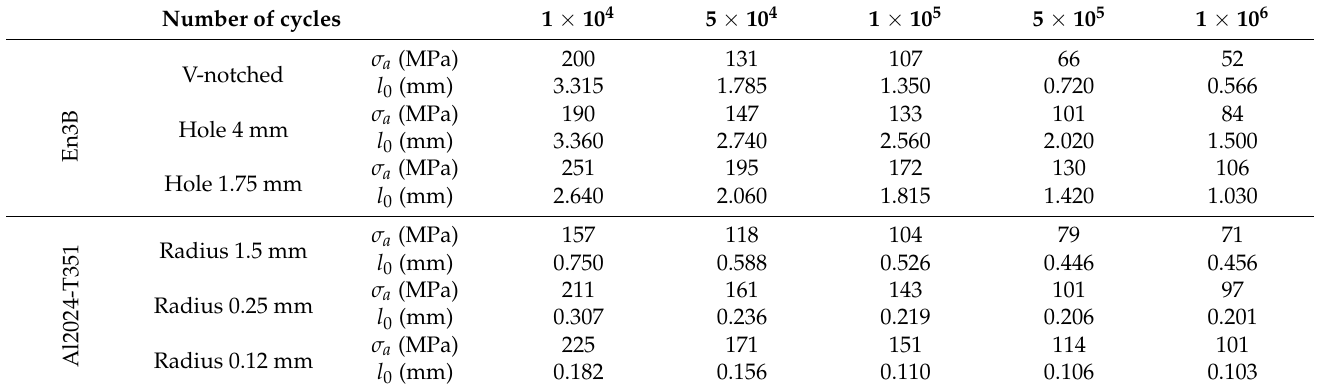
Table 1. Calculated critical distance for notched specimens [63].